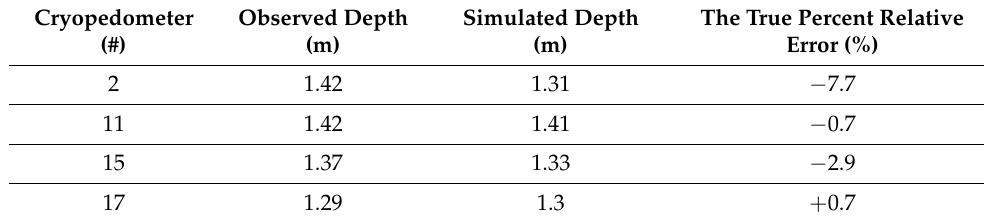
Table 6. Numerical errors of the simulated thaw